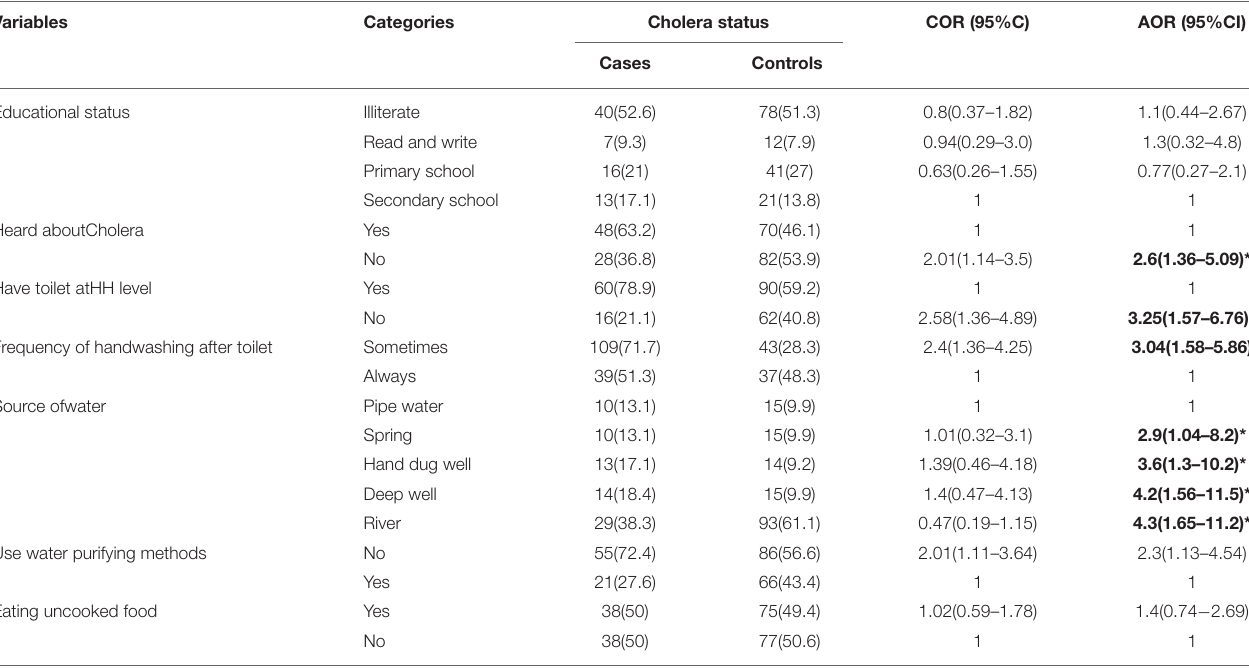
TABLE 5 | Multivariable analysis of determinants of cholera outbreak among population aged above 5 years in Somali Region, Ethiopia,